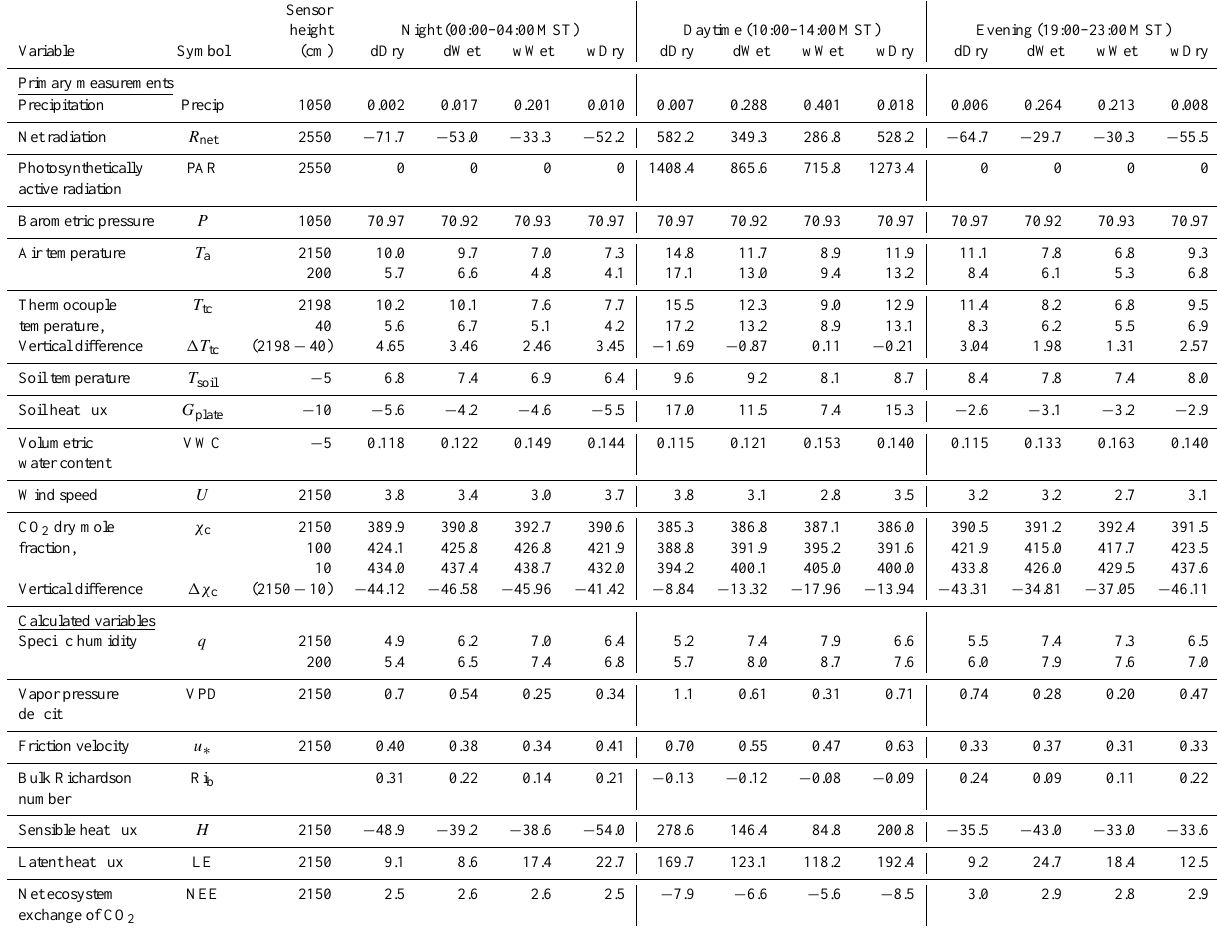
Table 3. Daytime and nighttime statistics of selected variables for different precipitation conditions. Sensor